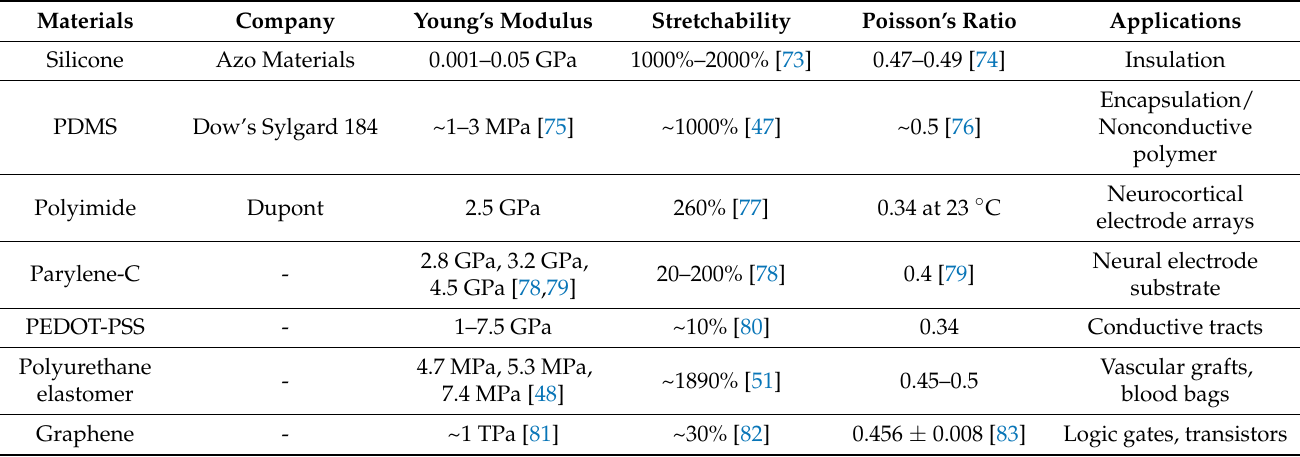
Table 2. Common bioelectronic materials with characteristics related to flexibility and stretchability. (all these values are for the listed applications, as each of the materials are highly